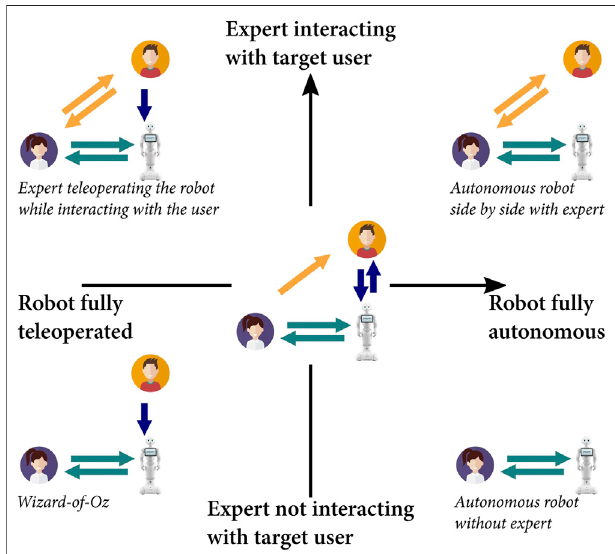
FIGURE 3 | Two-dimensional representation for visualising the different types of long-term expert-robot-user interactions that a social robot might be designedfor,allofwhichLEADORcanfacilitate.Notethatthisisnotadiscrete space, and LEADOR speci fi cally makes it possible to move along these axes upon real-world deployment. People vector created by studiogstock - www.freepik.com.